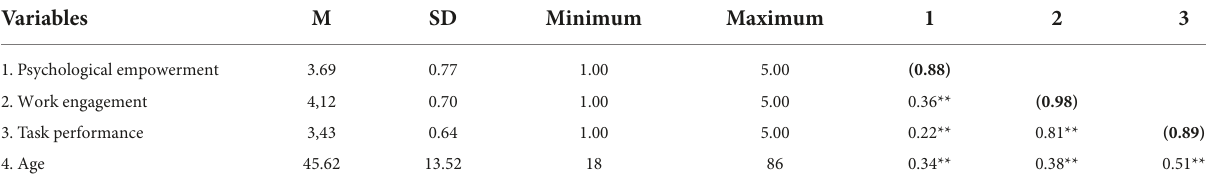
TABLE 2 Descriptive statistics and correlations.